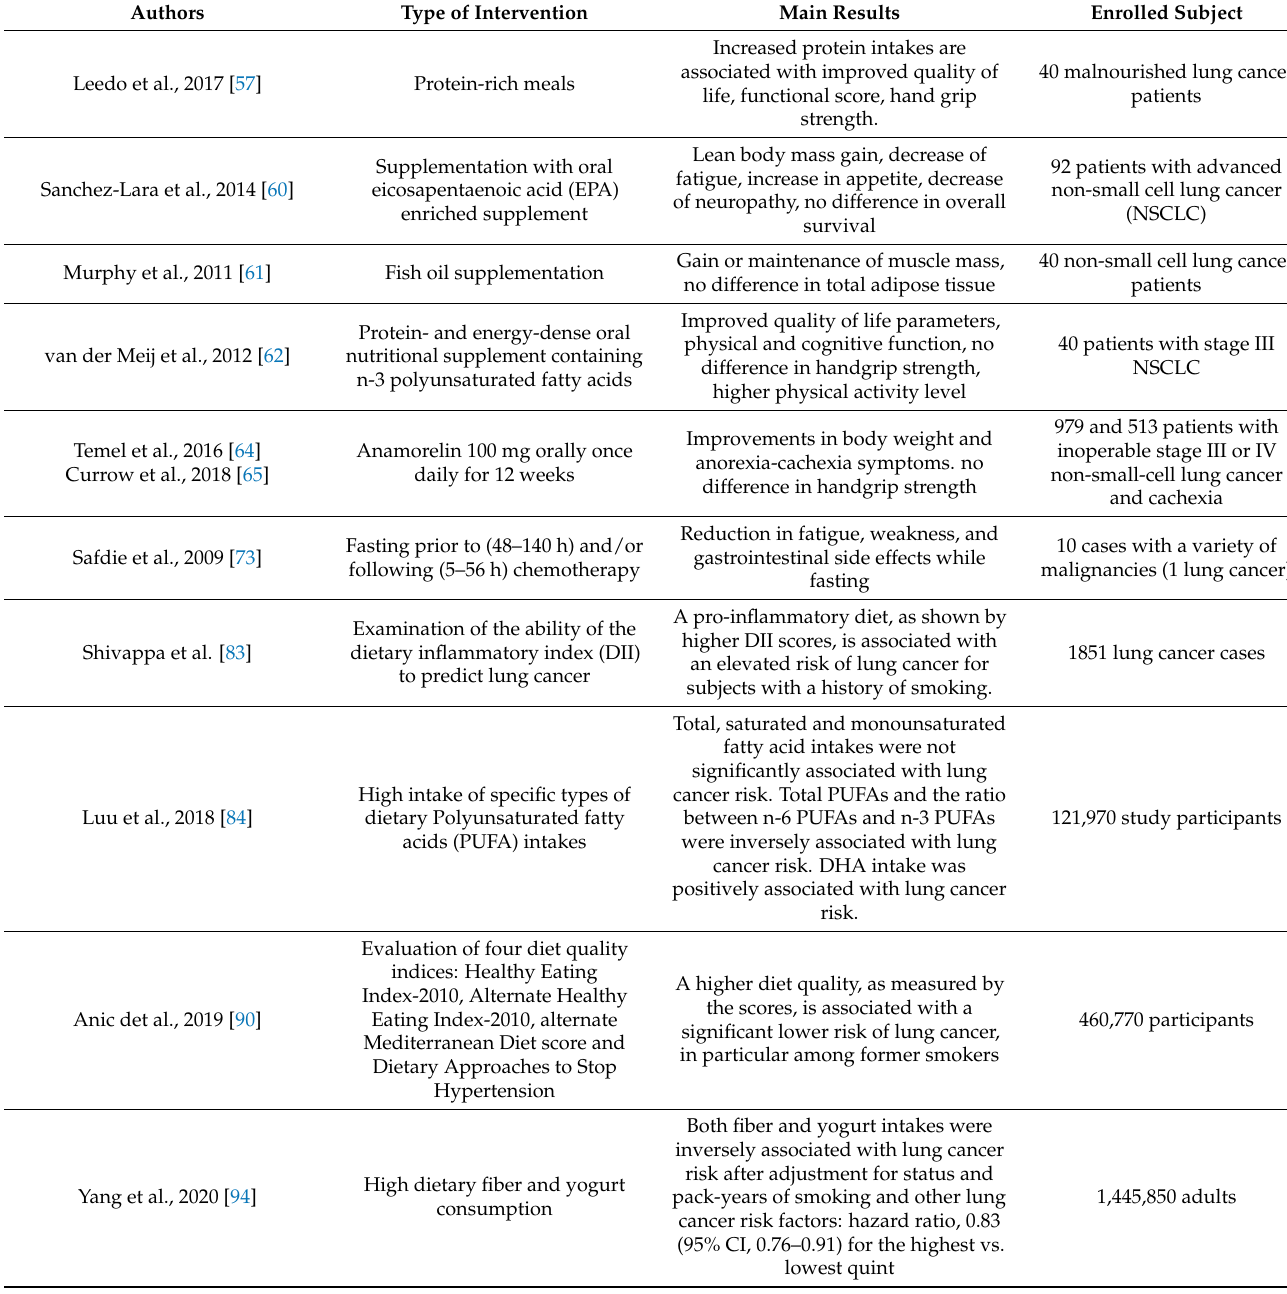
Table 1. Main results from human studies summarizing the effects of dietary and physical activity interventions in lung cancer